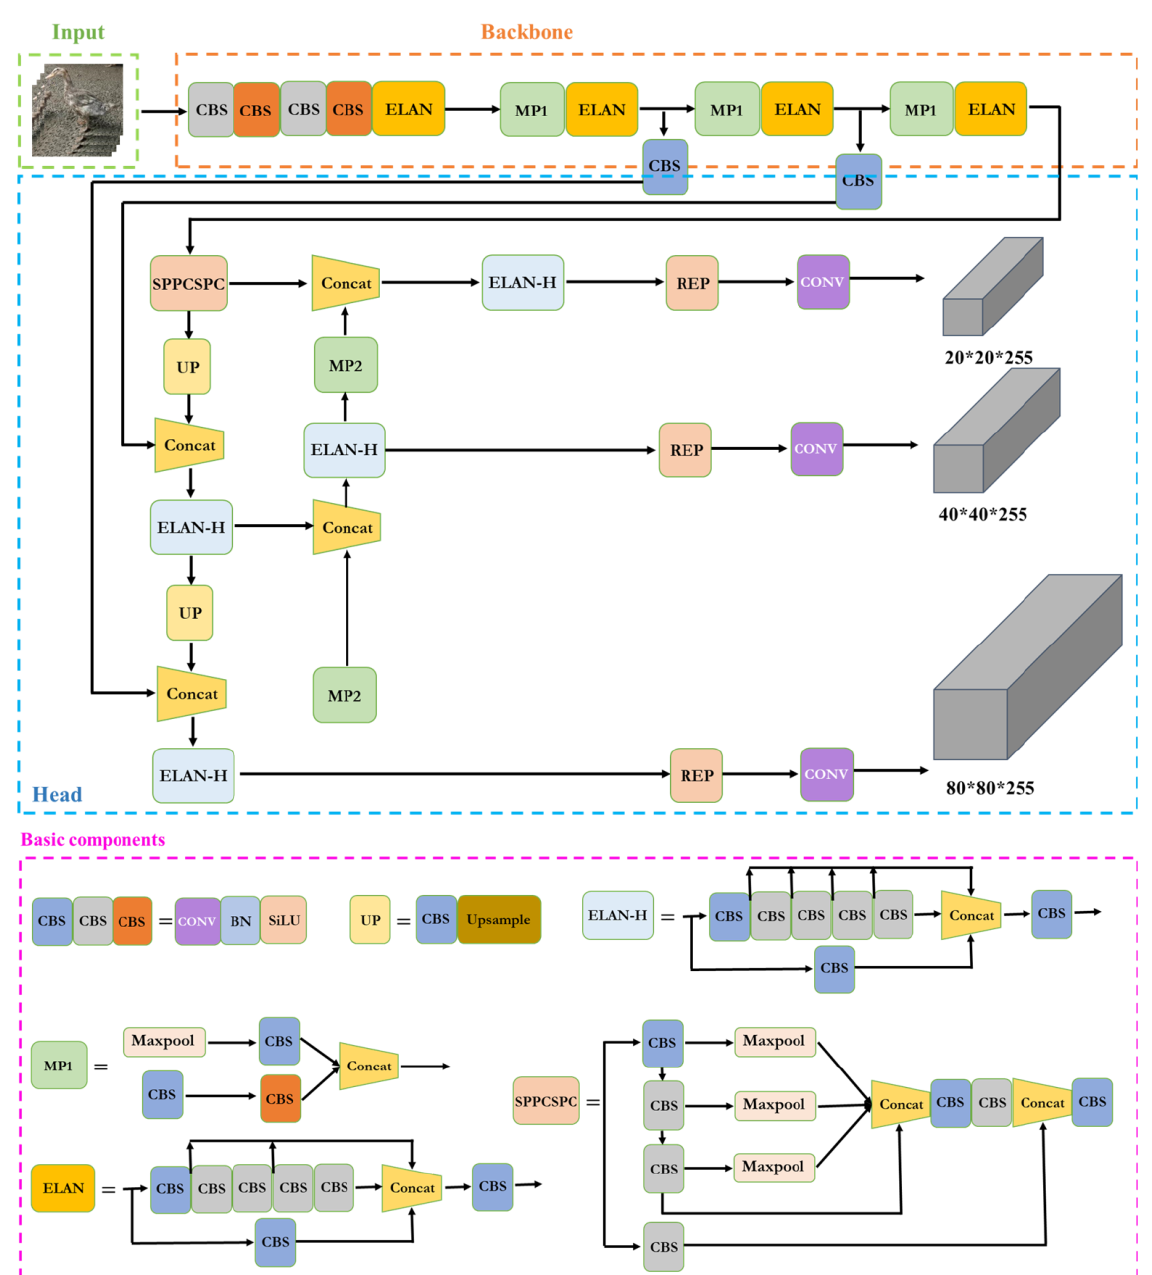
Figure 5. The network architecture diagram of Yolov7 contains four general modules: input terminal, backbone, head, and prediction, and five basic components: CBS, MP, ELAN, ELAN-H, and SPPCSPC.